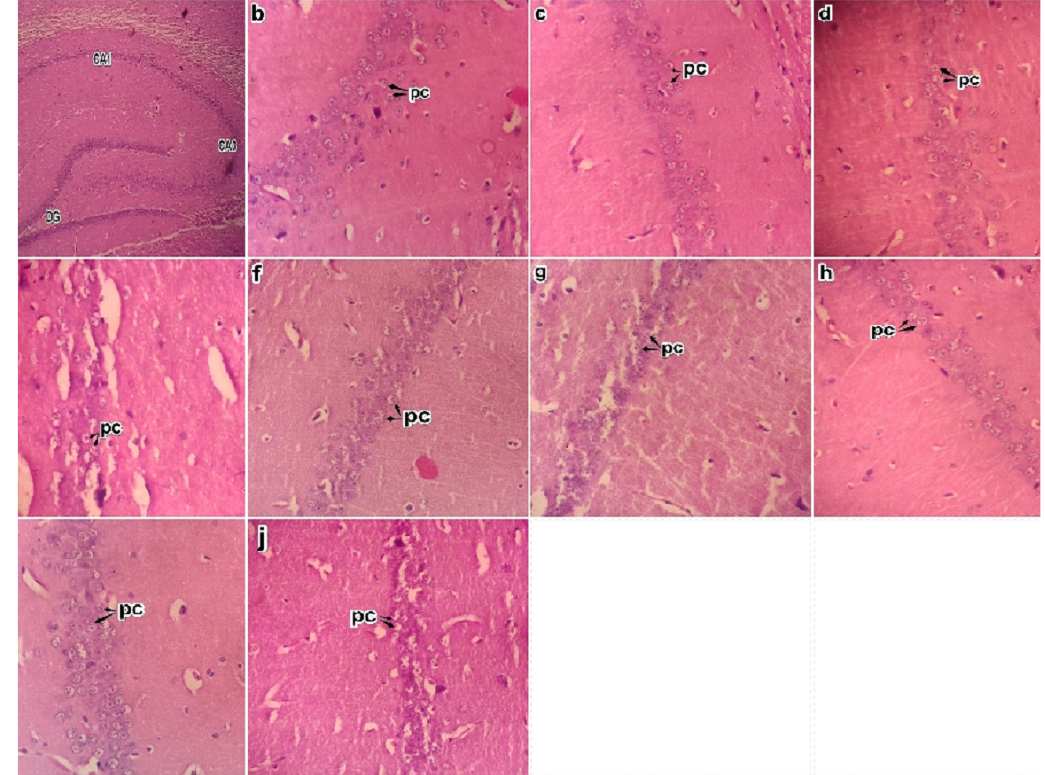
FIGURE S1 - H&E staining of pyramidal cells (pc) in the sagittal sections of hippocampus CA1 region. a: X40. In the following images X400 was applied: b (Ctr); c (S+W); d (R); e (Aβ); f (Aβ+W); g (Aβ+R), h (Aβ+T+100), i (Aβ+P+100), and j (Aβ+R+100). Please refer to the Methods and Materials section for the groups’ definitions. pc: pyramidal